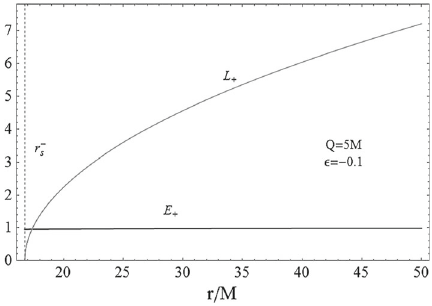
√ Fig. 29 Class : Q > 9 / 8 M and − M / Q < (cid:2) < 0. Parameter choice is as follows: Q = 5 M and (cid:2) = − 0 . 1. Then r − s = 16 . 7519 M . Circular orbits exist with angular momentum L = L + ( gray curve ) and energy E = E + ( black curve ) in r > r − s . For r = r − s , L =